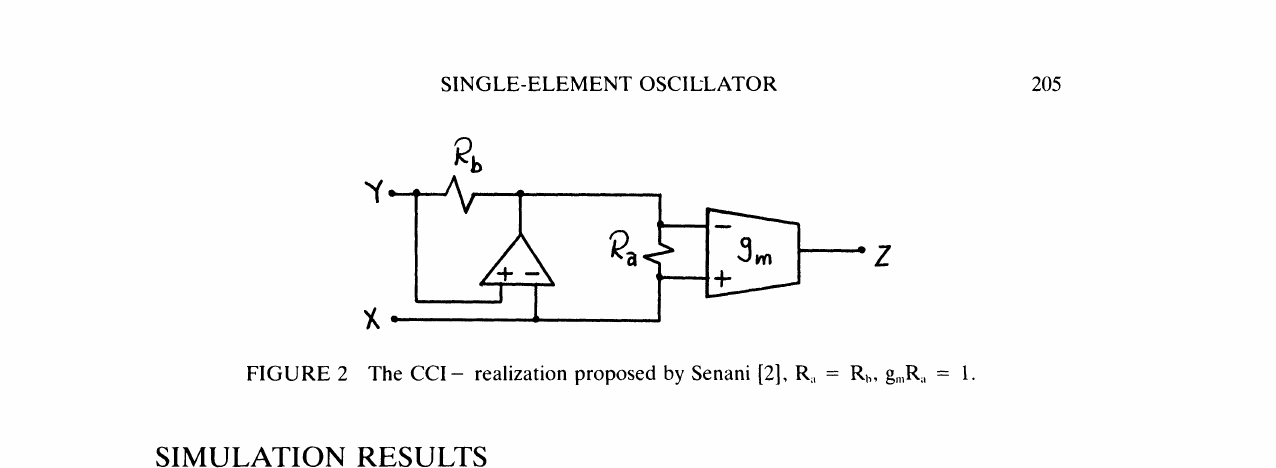
FIGURE 2 The CCI- realization proposed by Senani [2], R,, R,, g,.R,,